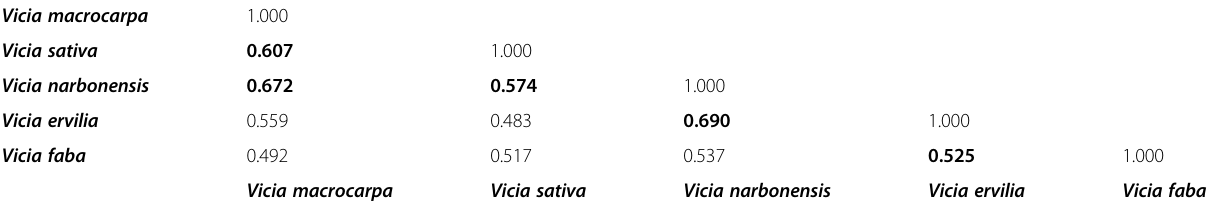
Table 4 The level of similarities among Vicia species, produced by Jaccard ̍ ’ s coefficient, based on collective date of seed water- soluble proteins and water non-soluble proteins